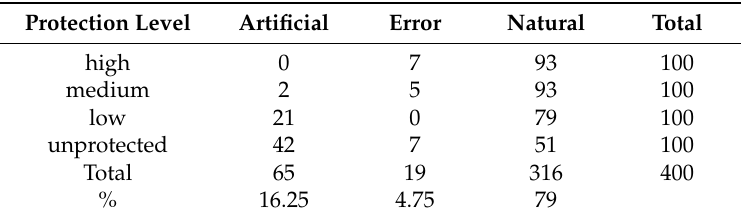
Table 3. Distribution of a random selection of 100 temporary water bodies from each protection level classified according to type of inundation. Protection Level